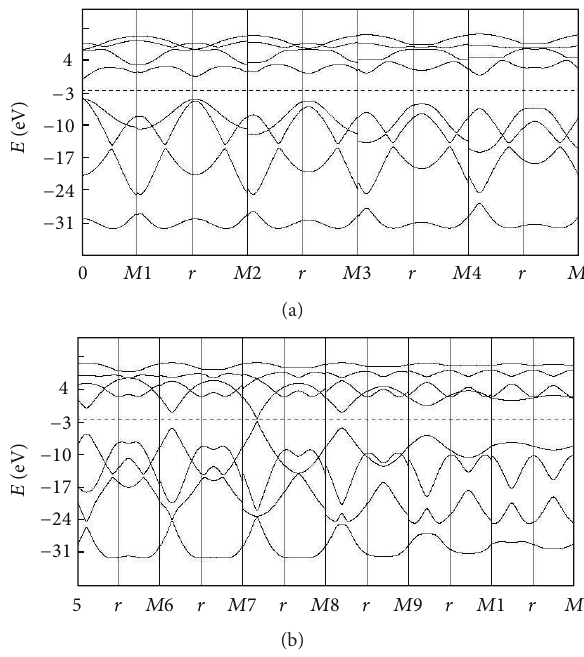
Figure 7: Effect of electron-vibration coupling on band structure topology at Fermi level for [(5,5),91] -type SWSiNT. Band structure at (a) equilibrium remains without change of topology at Fermi level (cf. path 0- 𝑀 for (a)/(b) panels) for (b) vibration motion in stretching Si–Si mode, which induces topology change in [(5,0),91]- type SWSiNT; cf. Figure 6(b)/Figure 7(b).